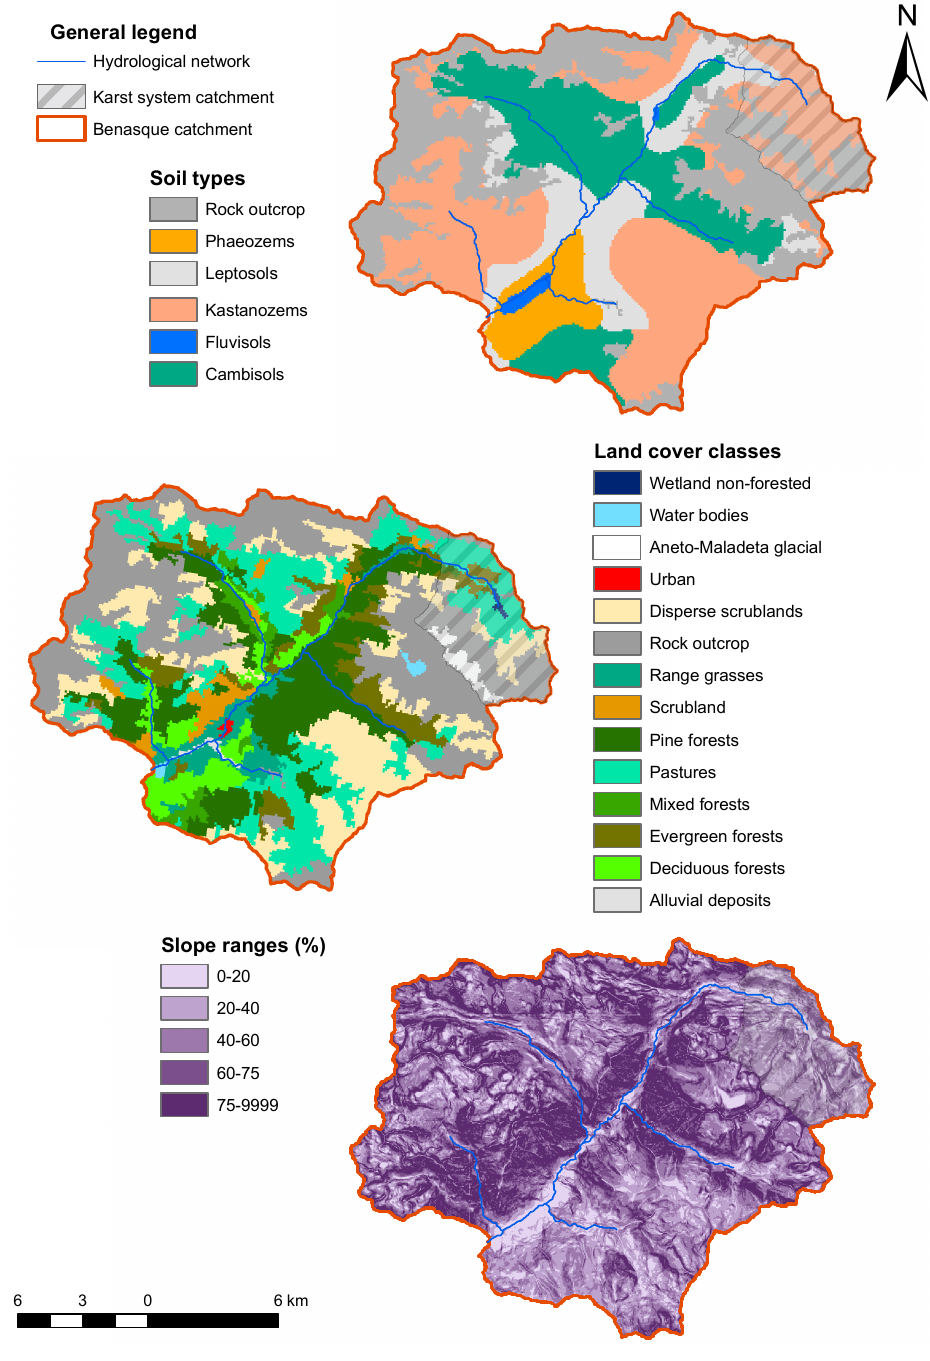
Figure 2. Distribution of soil types, land covers and slope ranges in the Benasque